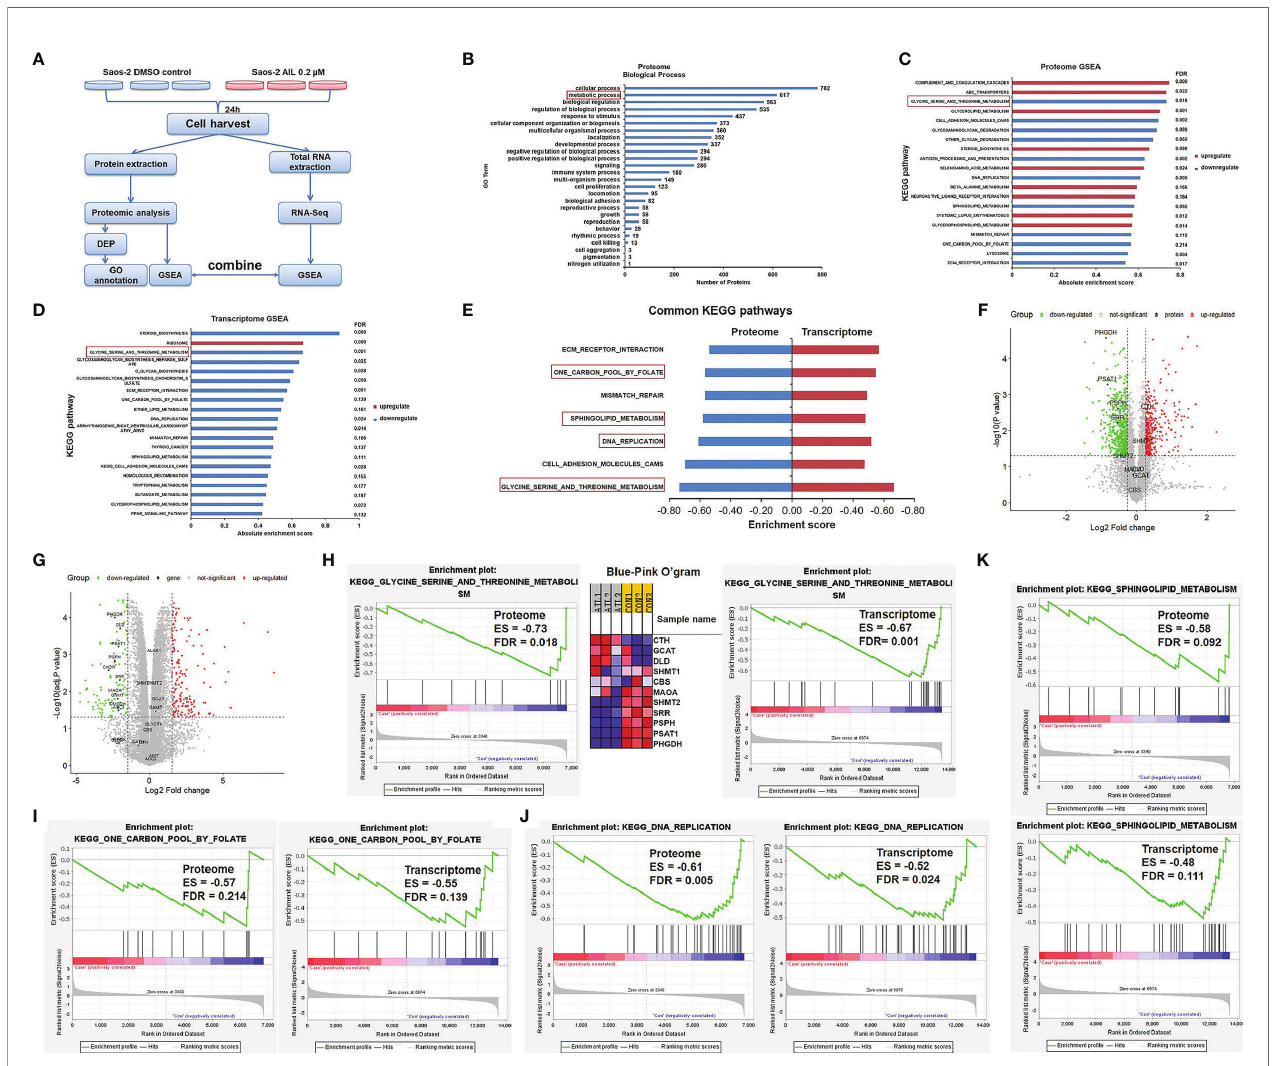
FIGURE 5 | Proteomics and transcriptomics analysis of AIL treated Saos-2 cells identi fi ed the SSP as a key target. (A) Schematic overview of proteomics and transcriptomics analysis of Saos-2 cells treated with AIL or DMSO. (B) Gene ontology (GO) annotation showed that 617 (68.6%) out of the 899 differentially expressed proteins are involved in metabolic process. (C) GSEA of proteome data, showing the top 20 signi fi cant altered KEGG pathways after AIL treatment. (D) GSEA of transcriptome data, showing the top 20 signi fi cant altered KEGG pathways after AIL treatment. (E) Details of the 7 common KEGG pathways from proteome and transcriptome data. (F) Volcano plot of the global pro fi le of proteins after AIL treatment, marked black proteins are involved in the serine biosynthetic or metabolic pathway. (G) Volcano plot of the global pro fi le of mRNA after AIL treatment, marked black genes are involved in the serine biosynthetic or metabolic pathway. (H) Enrichment plot and Blue-Pink O ’ gram of the glycine, serine and threonine metabolism pathway from proteome and transcriptome data. (I) Enrichment plots of the KEGG one-carbon pool by folate pathway from proteome and transcriptome data. (J) Enrichment plots of the KEGG DNA replication pathway from proteome and transcriptome data. (K) Enrichment plots of the KEGG sphingolipid metabolism pathway from proteome and transcriptome